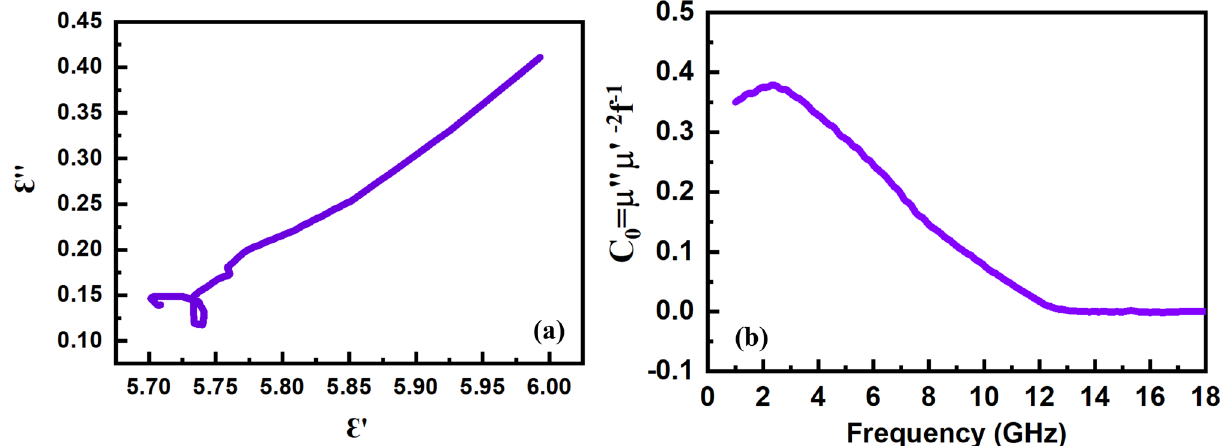
Figure 8. ( a ) Cole–Cole plot and ( b ) frequency dependence of μ ″ (μ ′ ) −2 f −1 of the sample sintered at 1300 °C.